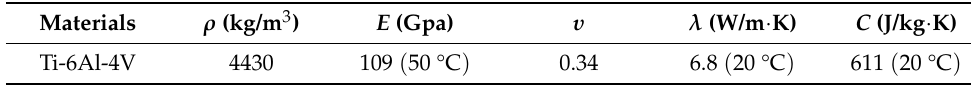
Table 6. The physical parameters of Ti-6Al-4V.